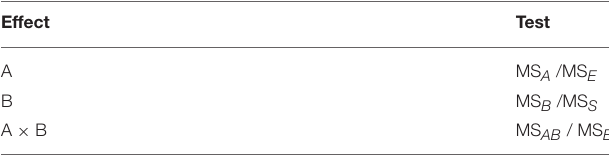
TABLE 4 | The EMS ratios used to form appropriate F -tests for the main effects and interactions in a 2-way mixed-measures ANOVA.